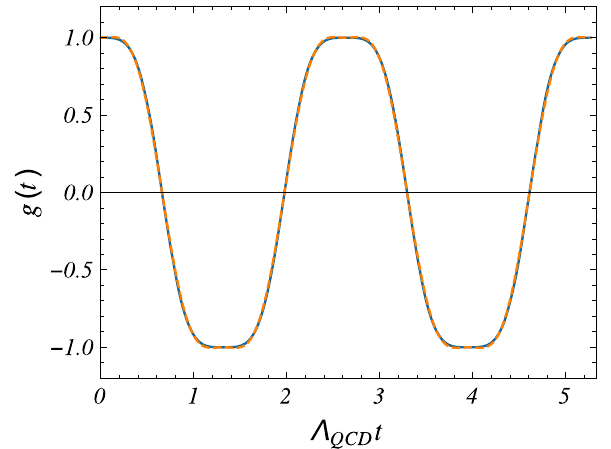
Fig. 6 The time dependence of the quasi-harmonic universal function g = g ( t ) corresponding to the exact solution (B16) (solid line) com- pared to its Fourier approximation (B20) (dashed line)